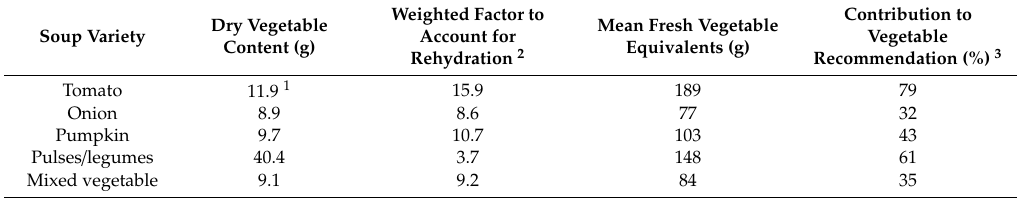
Table 4. Vegetable content of dry vegetable soups per 250 mL serving.